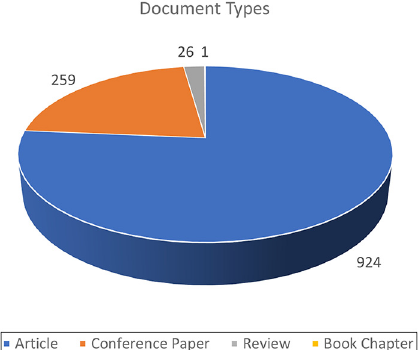
Figure 2. Document type